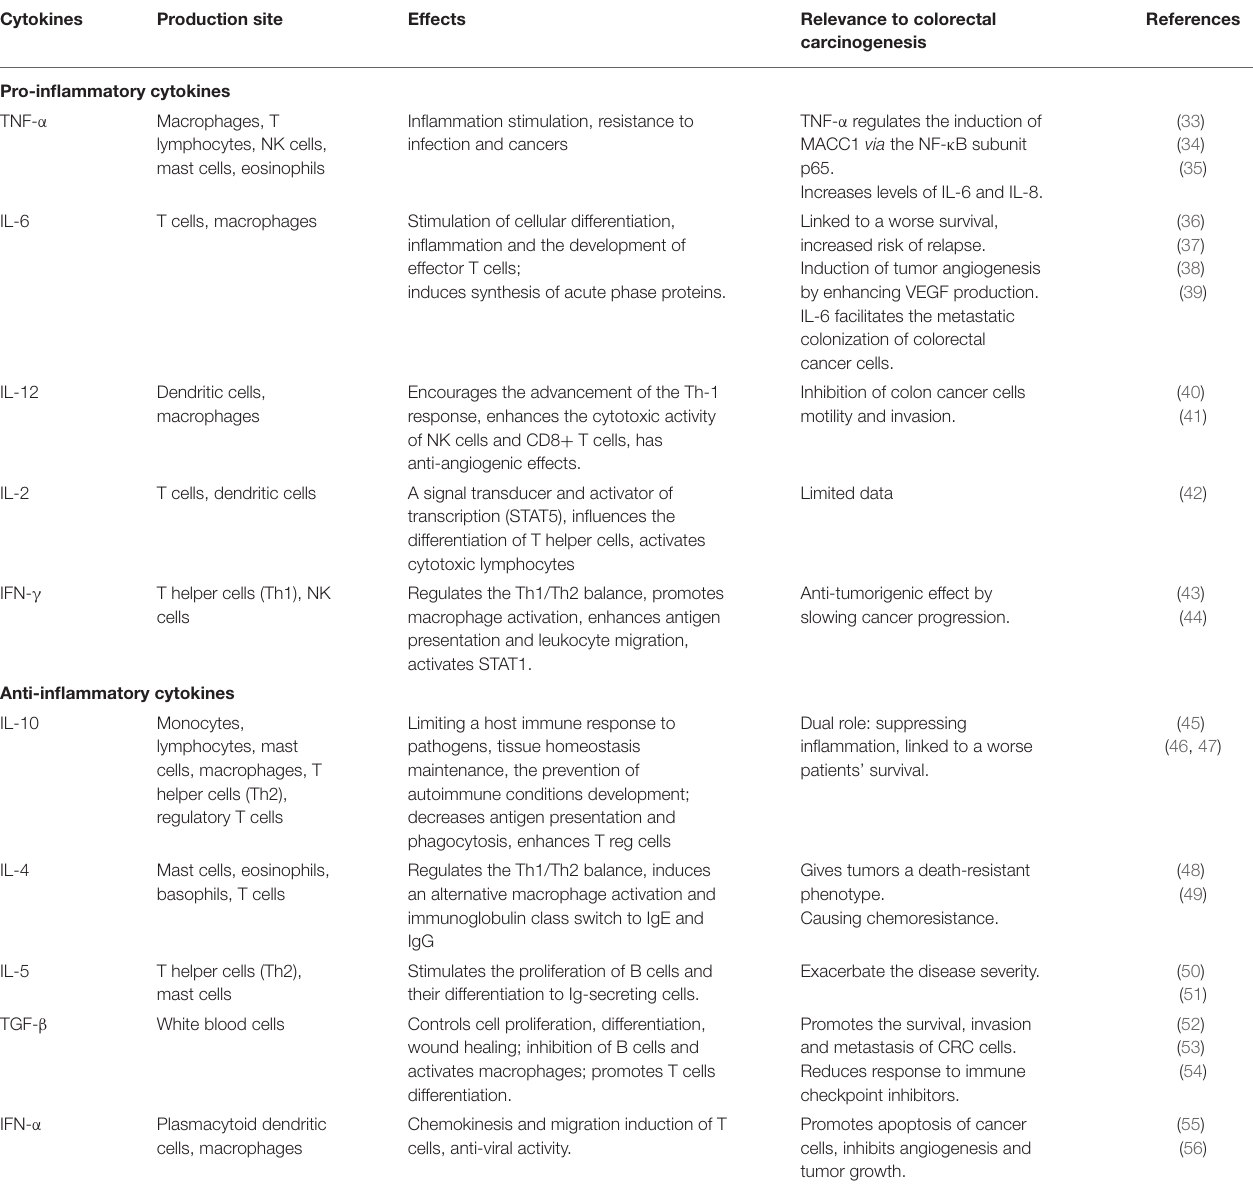
TABLE 2 | The main effects of pro- and anti-inflammatory cytokines.